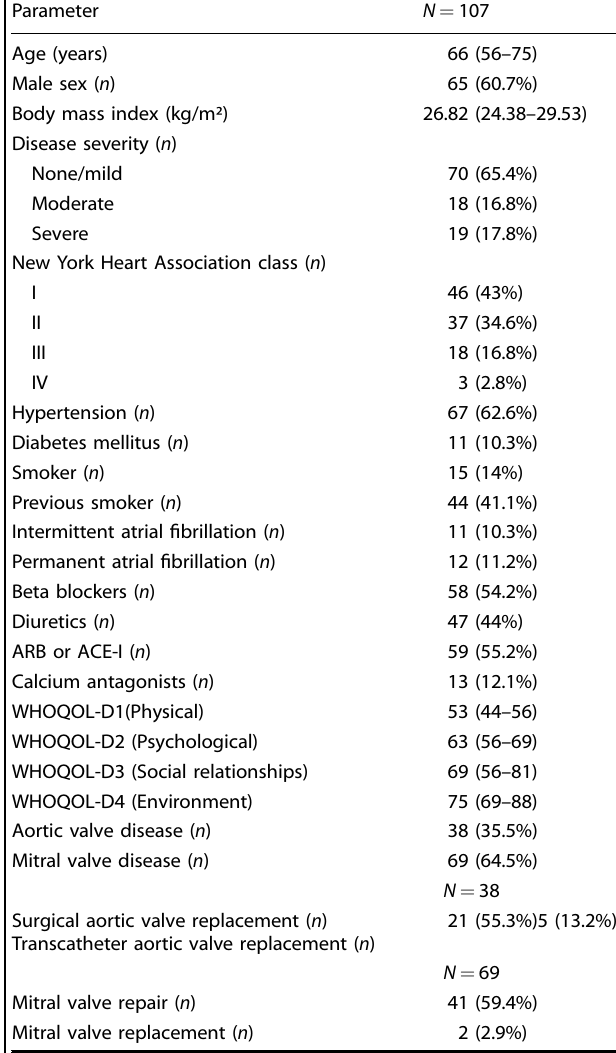
Table 1. Baseline